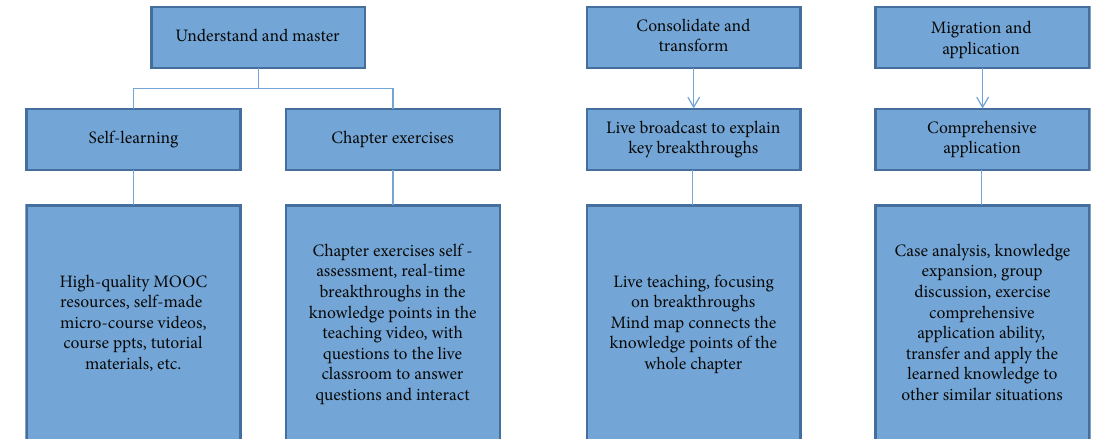
Figure 4: Initial attempt of mixed teaching mode.